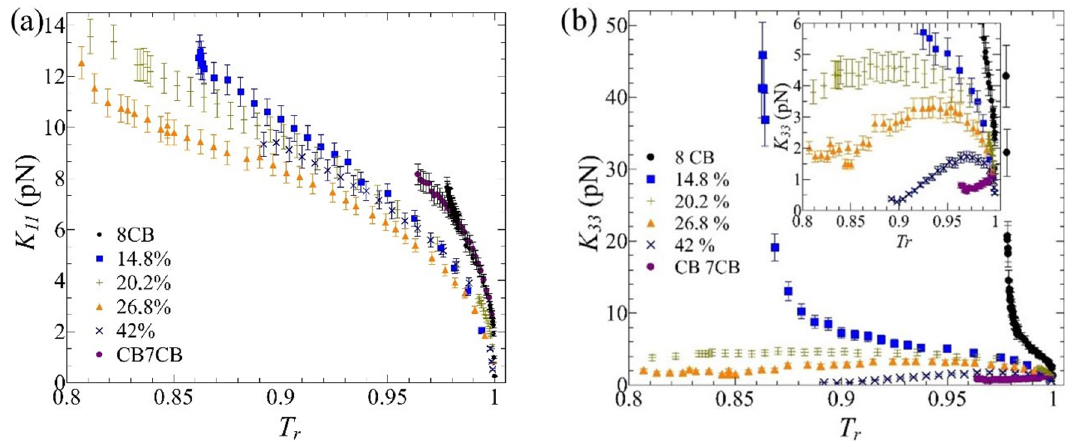
Figure 9. Evolution of the ( a ) splay K 11 and ( b ) bend K 33 elastic constants of the mixtures as a function of the reduced temperature Tr. Inset of ( b ) shows a zoomed region of the K 33 axis between 0 and 6 pN.